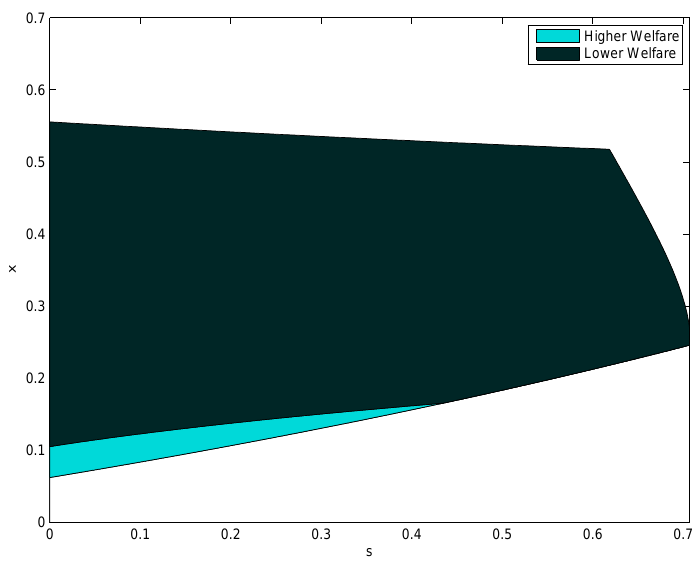
Figure 3: Ex-ante welfare in the cost-dependent equilibrium with an overconfi- dent player versus welfare with two rational players